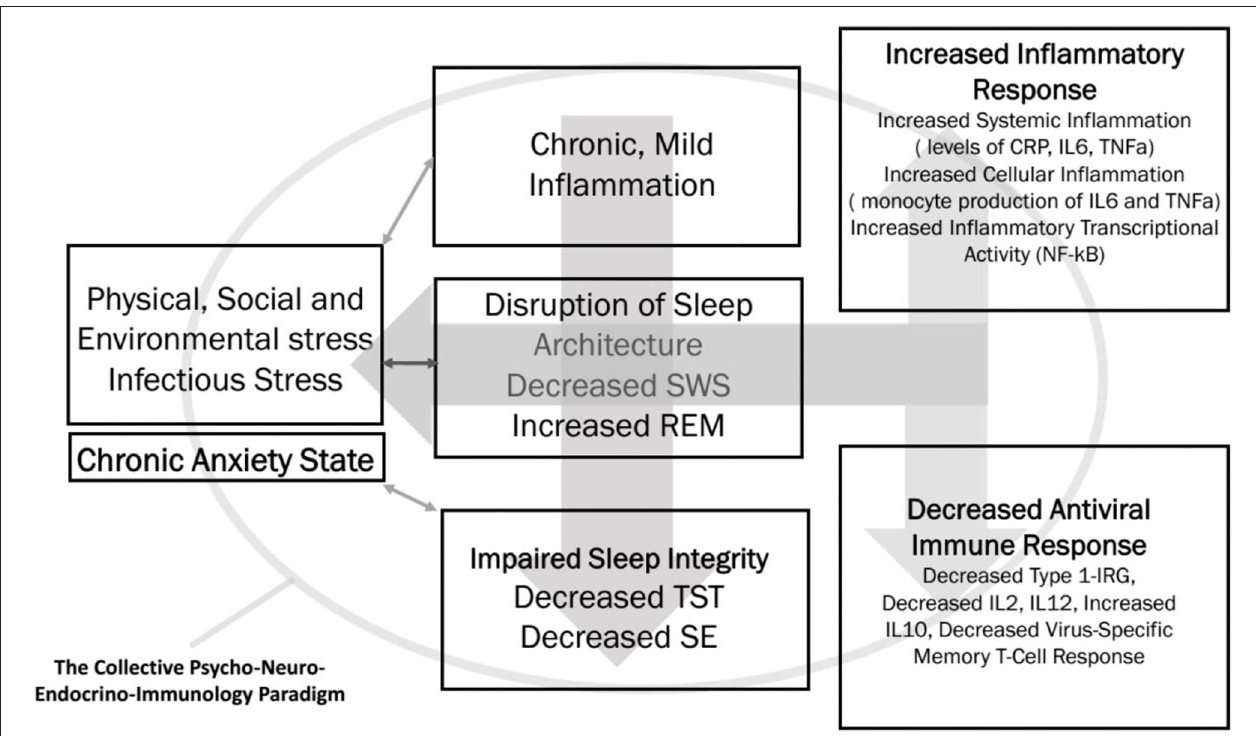
FIGURE 1 | The trilateral interface of chronic anxiety, sleep efficiency, and innate immunity is summarized. SWS, slow wave sleep; REM, rapid eye movement; TST, total sleep time; SE, sleep efficiency; CRP, C-reactive protein; IL, interleukin; TNF- α , tumor necrosis factor- α ; NF- κ B, nuclear factor κ B; IRG, interferon response gene.